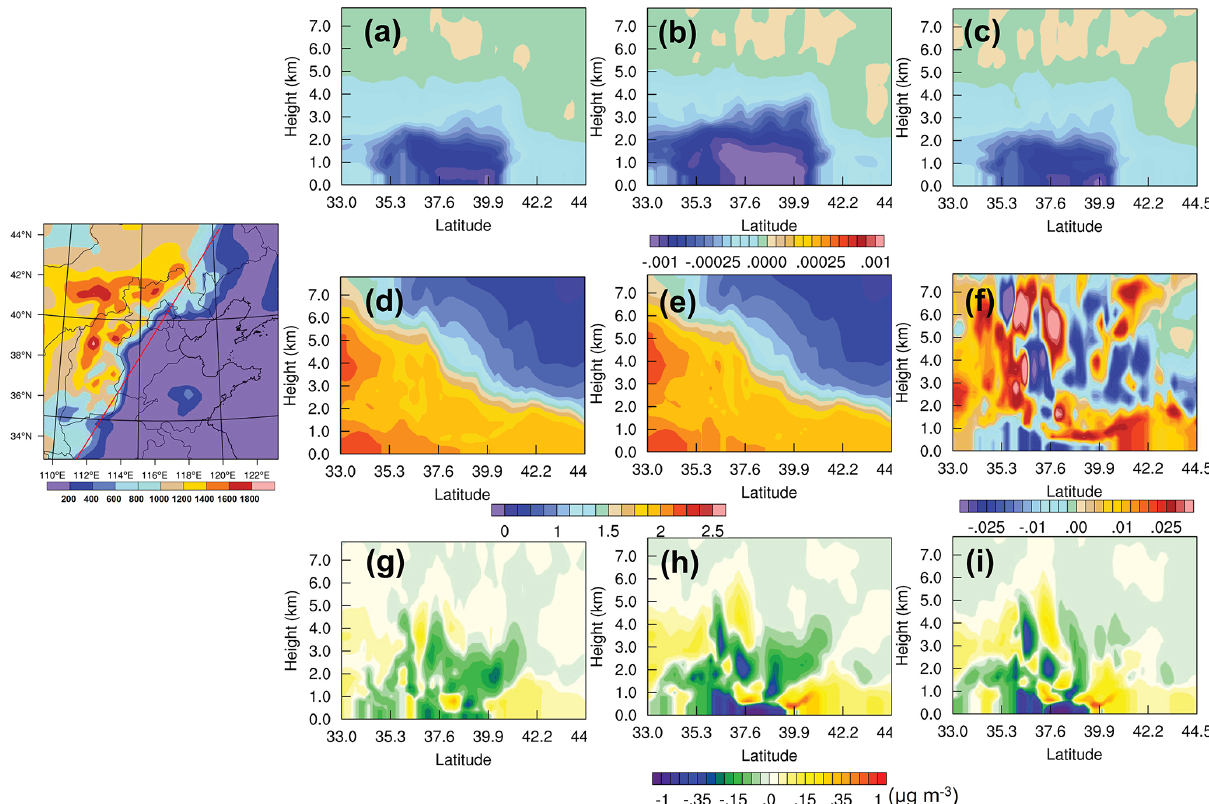
Figure 6. Cross sections of daytime (10:00–17:00 local time) mean changes in BC absorption coefficient (first row, CTL minus NOCTL), E ab (second row), BC absorption induced changes after emission reductions (CTL minus NOCTL) in PM 2 . 5 (third row); first, second, and third columns represent (cid:49) emission-Ext , (cid:49) emission-CS , and (cid:49) aging